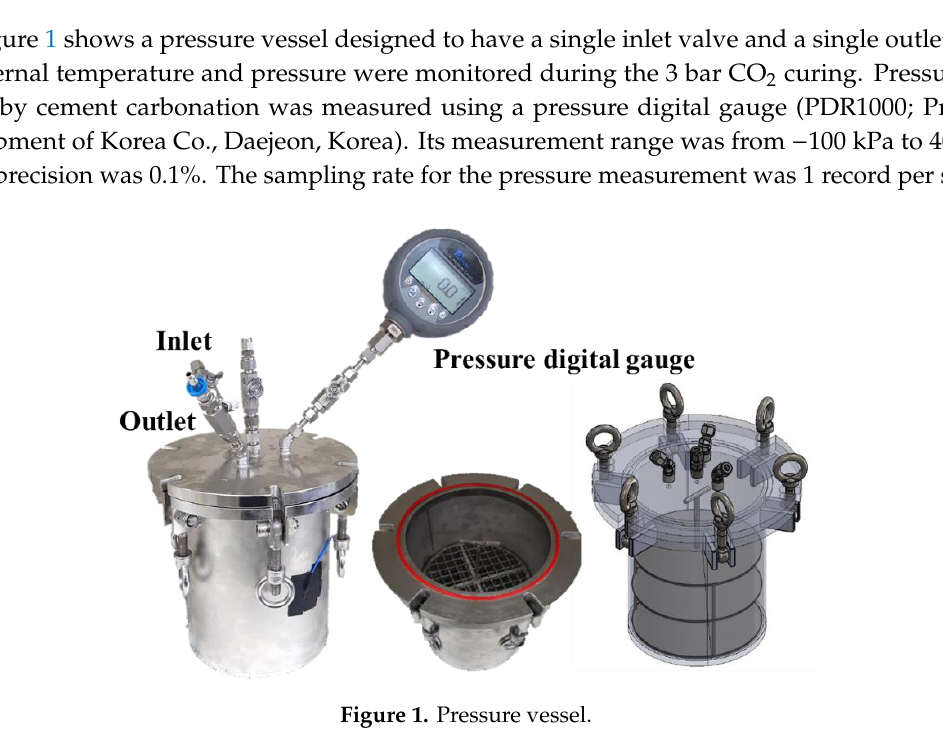
Table 3. Curing condition and sequence for samples.